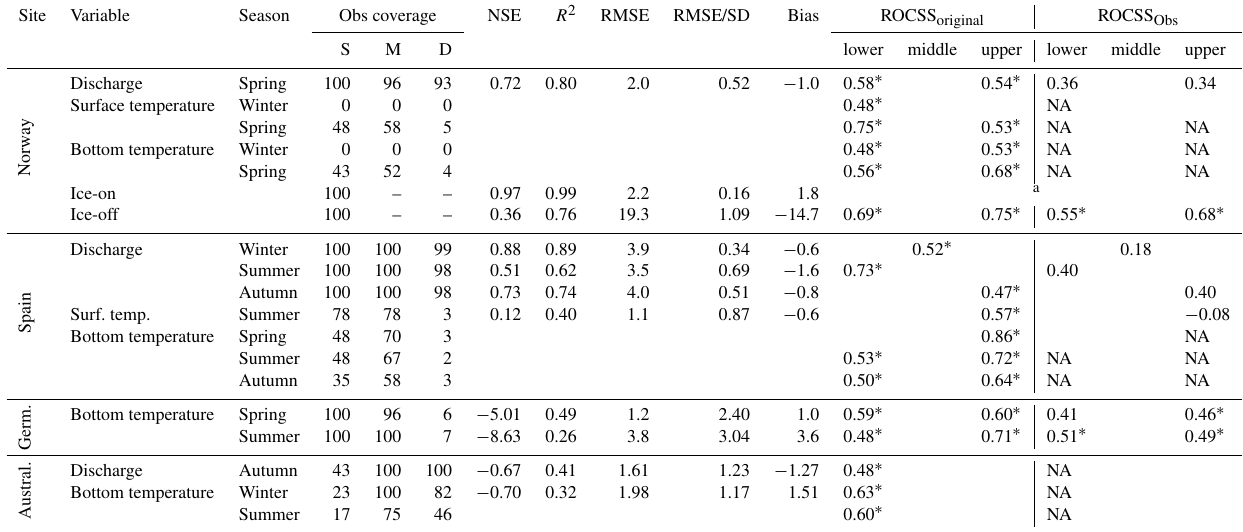
Table 7. Verification statistics (NSE, R 2 , RMSE, RMSE/SD, bias) for Lake_PO seasonal means (comparing Lake_PO to observations), as well as comparison of the ROCSS original (comparing Lake_F and Lake_PO) and ROCSS Obs (comparing Lake_F and lake observations). Site